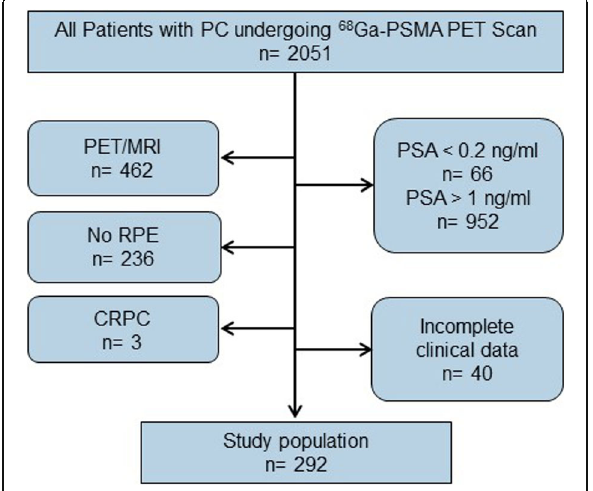
Fig. 1 Patient selection flow chart. PC, prostate cancer; RP, radical prostatectomy; CRPC, castration resistant prostate